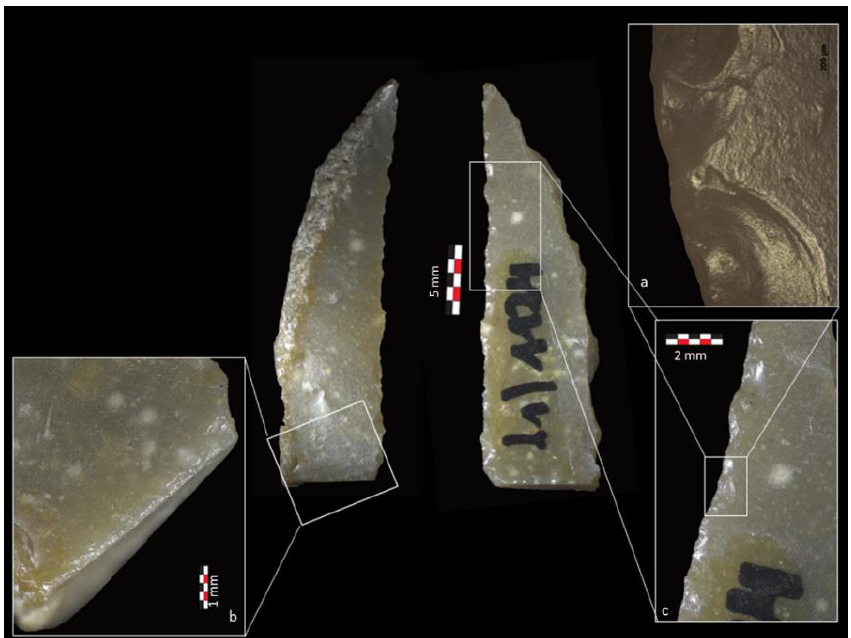
Figure 13. Macro and microscopic details of surface alterations caused by aeolian erosion on the curved backed point L11124 which hindered the impact fracture analysis: a) microscopic detail of the edge scarring (see picture c)) with visible edge rounding and surface gloss; b) proximal edge scarring; c) lateral edge scarring.